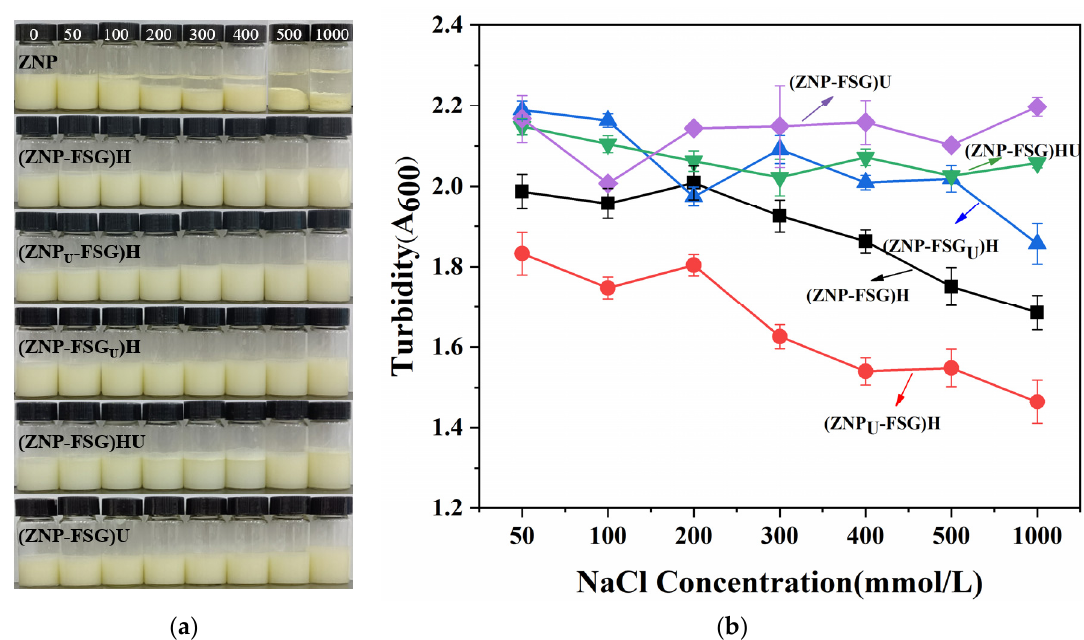
Figure 4. Visual appearance ( a ) and turbidity ( b ) of various ZNP-FSG complexes prepared in different NaCl concentration, i.e., black for (ZNP-FSG)H, red for (ZNP U -FSG)H, blue for (ZNP-FSG U )H, green for (ZNP-FSG)HU, and purple for (ZNP-FSG)U.